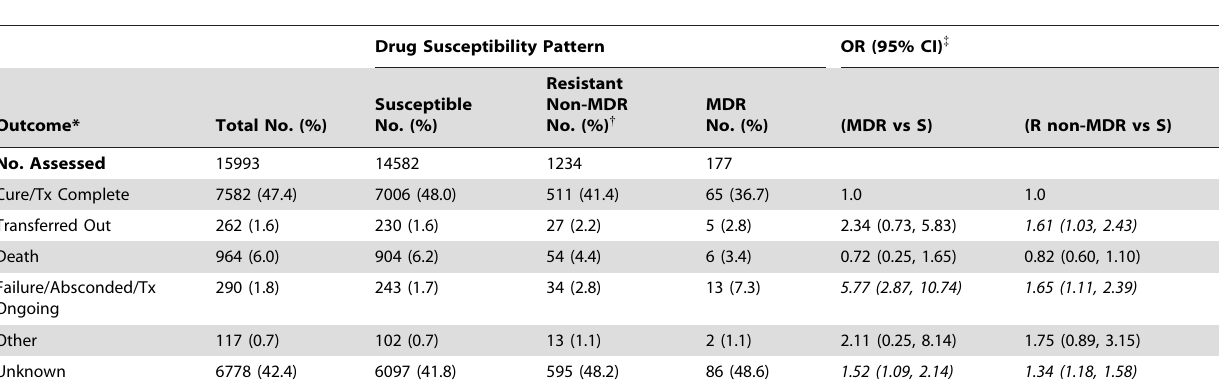
Table 4. Outcome of treatment of culture-positive tuberculosis cases in Canada by drug susceptibility pattern of incident case isolate (1997–2008).